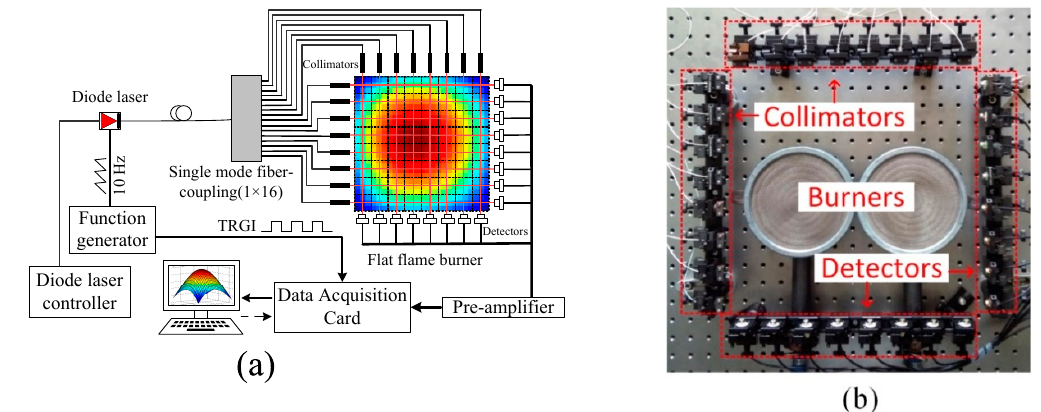
Figure 7. The experimental system. ( a ) The scheme of the tunable diode laser absorption tomography (TDLAT) system with 8 × 8 grids, ( b ) the photograph of the optical test section: left and upper are 16 collimators, right and under are 16 detectors.